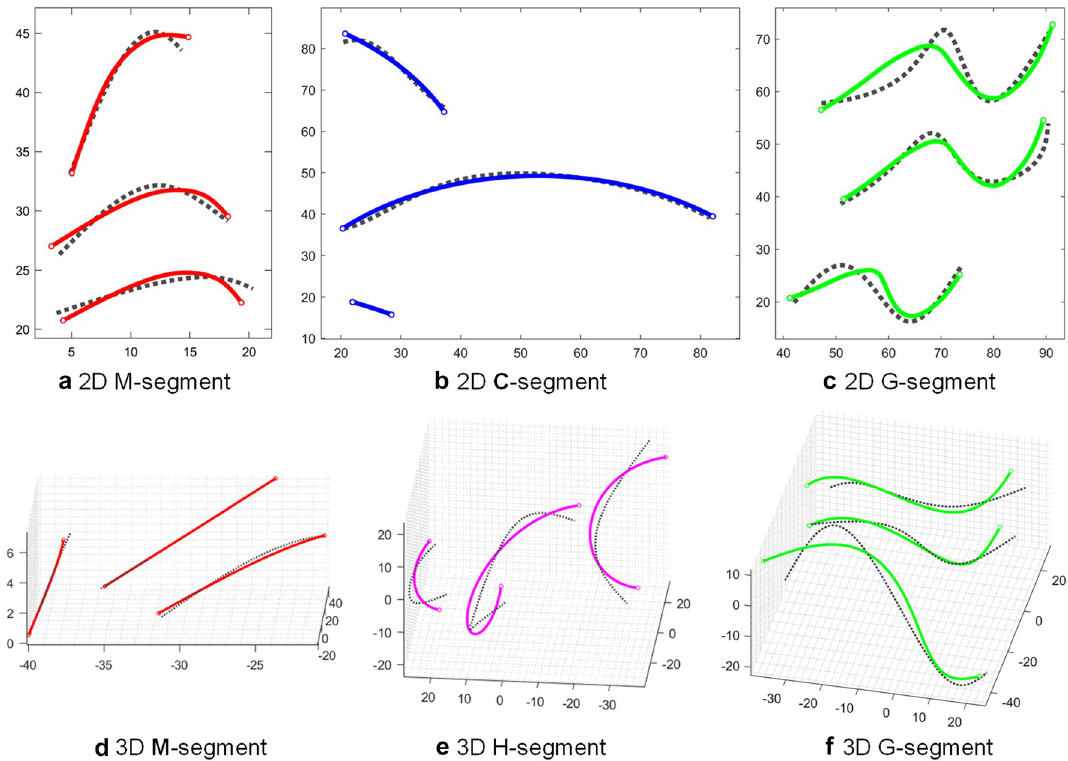
Figure 2. Different types of segments (shown in solid lines) approximate portions of 2D (first row) and 3D (second row) target profiles (shown in dashed